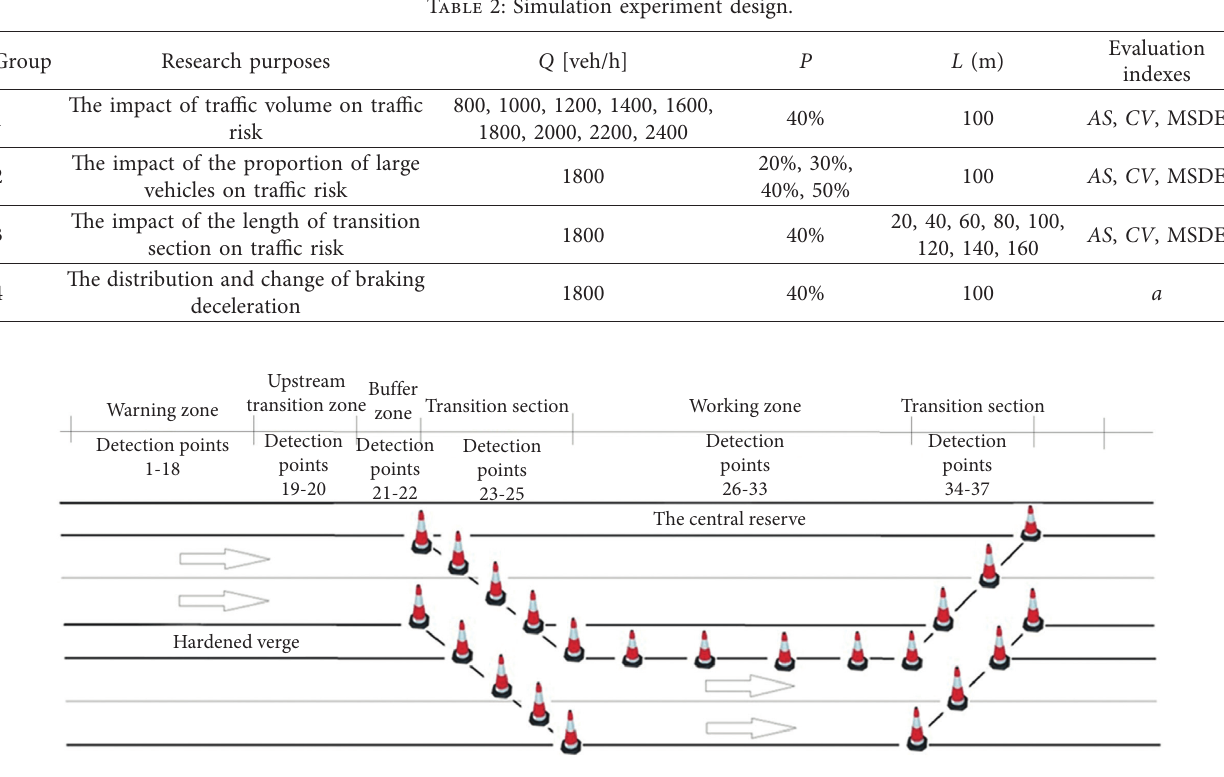
Figure 3: The layout of data detection points.